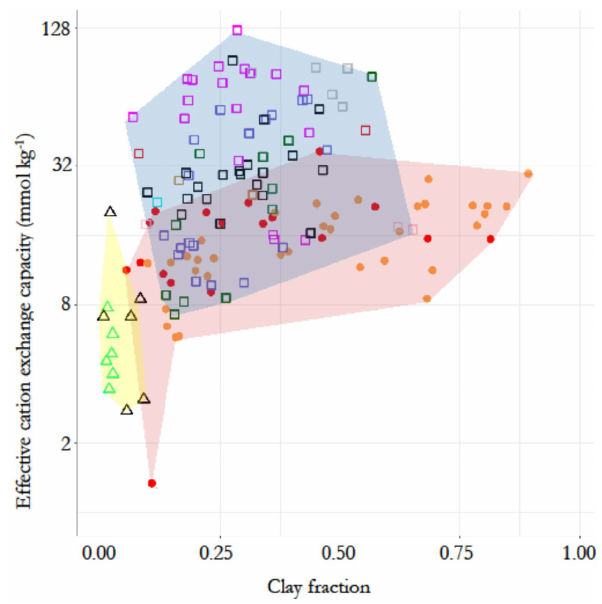
Figure 2. Contrasting chemical characteristics of the three soil groups, evidenced by the relationship between top-soil clay frac- tion and effective cation exchange capacity (0–30cm). Triangles with yellow background represent the arenic soil group, consist- ing of Arenosols (green) and Podzols (black). Filled circles with pink background represent the low-activity clay soils (LACs) which consists of Ferralsols (yellow) and Acrisols (red). Soils with high- activity clay (HAC) are shown as open squares with light blue background. They are the Alisol (black), Cambisol (pink), Fluvi- sol (grey), Gleysol (green), Leptosol (brown), Lixisol (red), Luvi- sol (purple), Plinthosol (blue), Regosol (cyan) and Umbrisol (light green) soil